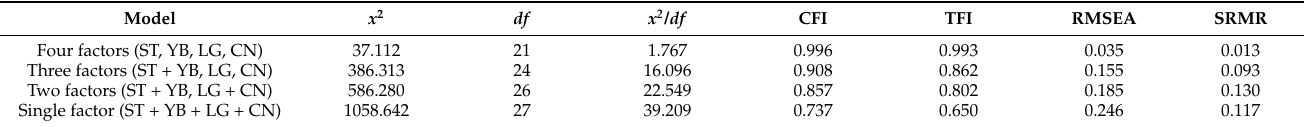
Table 1. Confirmatory factor analysis results o f each test